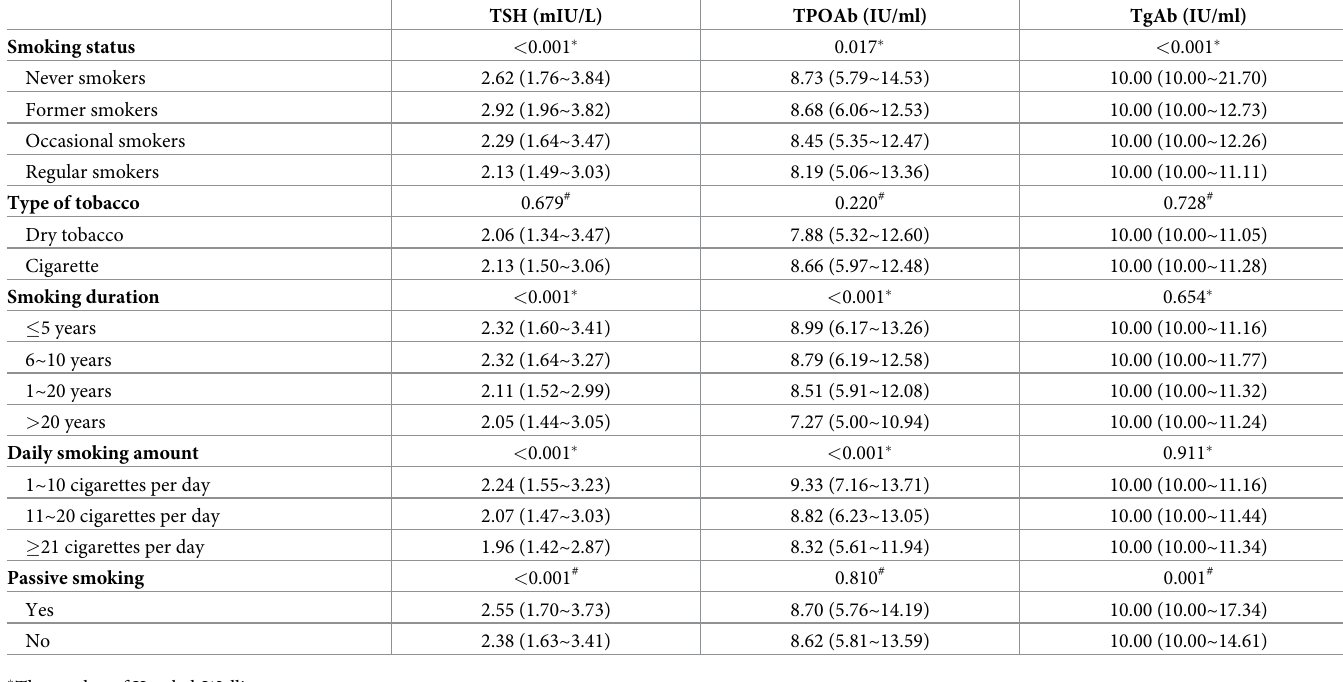
Table 2. Concentrations of TSH, TPOAb and TgAb among different smoking status groups (Median, P 25 ~P 75